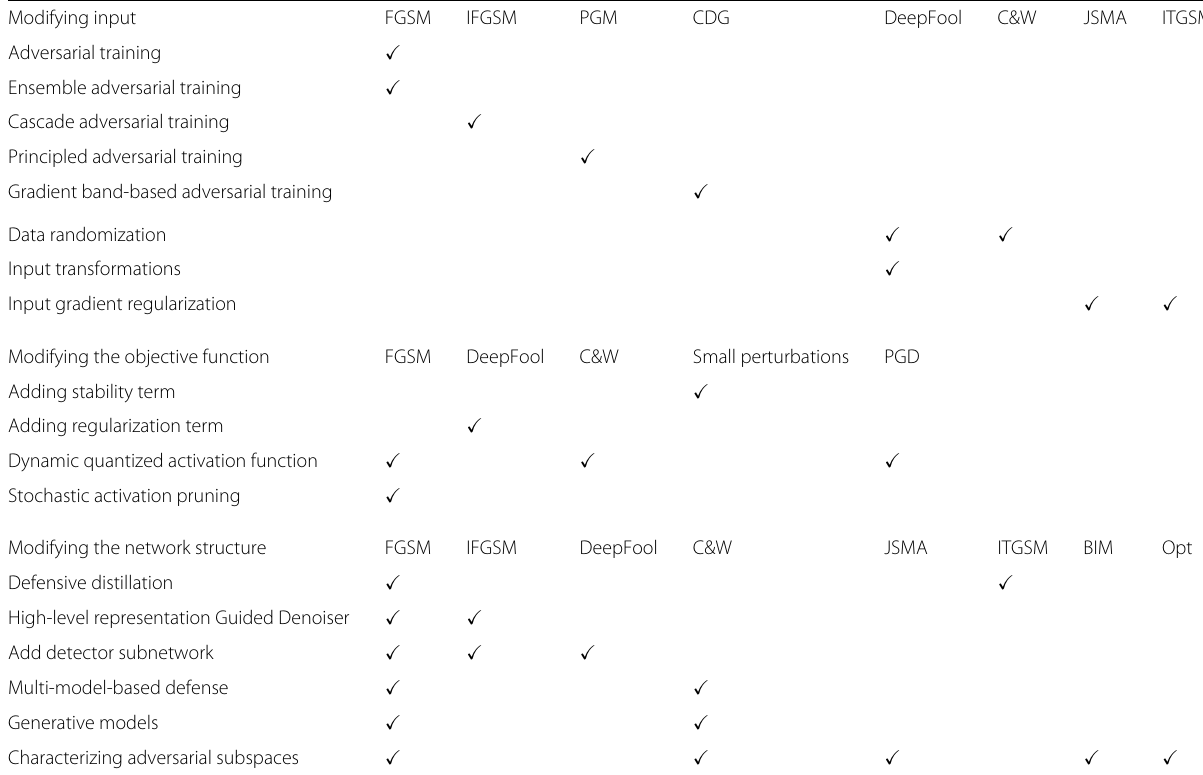
Table 4 Different attacks targeted by different defense